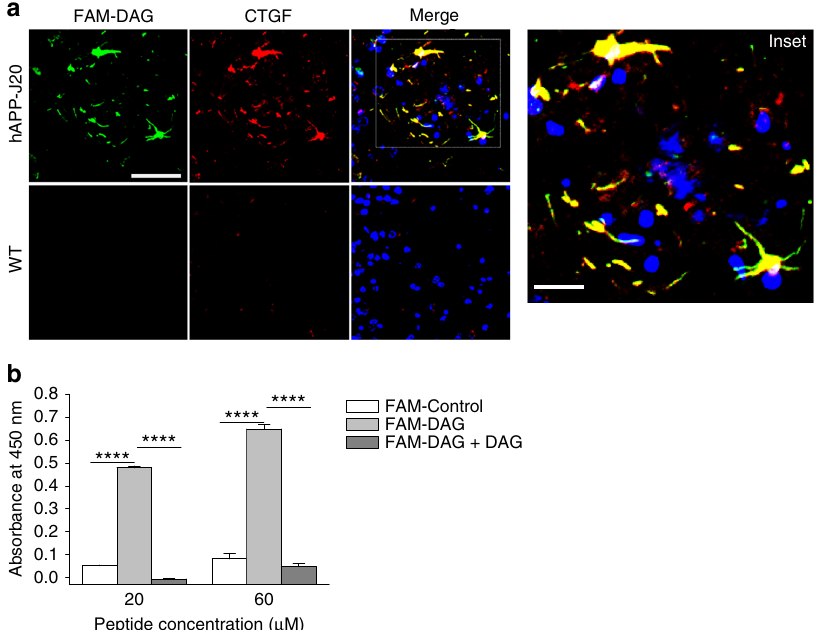
Fig. 3 Identi fi cation of a receptor for DAG. a DAG colocalizes with connective tissue growth factor, CTGF. FAM-DAG was intravenously injected in 9-month-old hAPP-J20 and WT mice, allowed to circulate for 30 minutes, after which mice were perfused, and the brains were fi xed, sectioned and stained for FAM ( green ) and CTGF ( red ). The region shown is the hippocampus. Scale bars , 50 µ m (20 µ m for inset ). Representative images are shown. b DAG binds to recombinant CTGF. FAM-DAG was incubated on ELISA plate coated with recombinant human CTGF at two different peptide concentrations of the FAM peptide alone ( light gray bars ), or in the presence of non-labeled DAG (0.6 mM) ( dark gray bars ). The control peptide did not show signi fi cant binding to CTGF under the same conditions ( open bars ). Non-labeled DAG inhibited the binding of FAM-DAG, demonstrating speci fi city of the CTGF